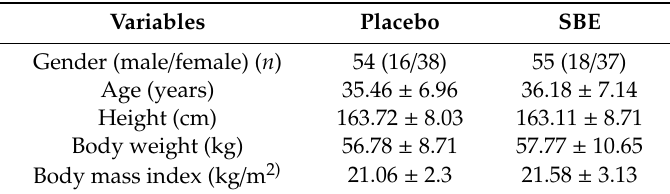
Table 3. Subjects’ background